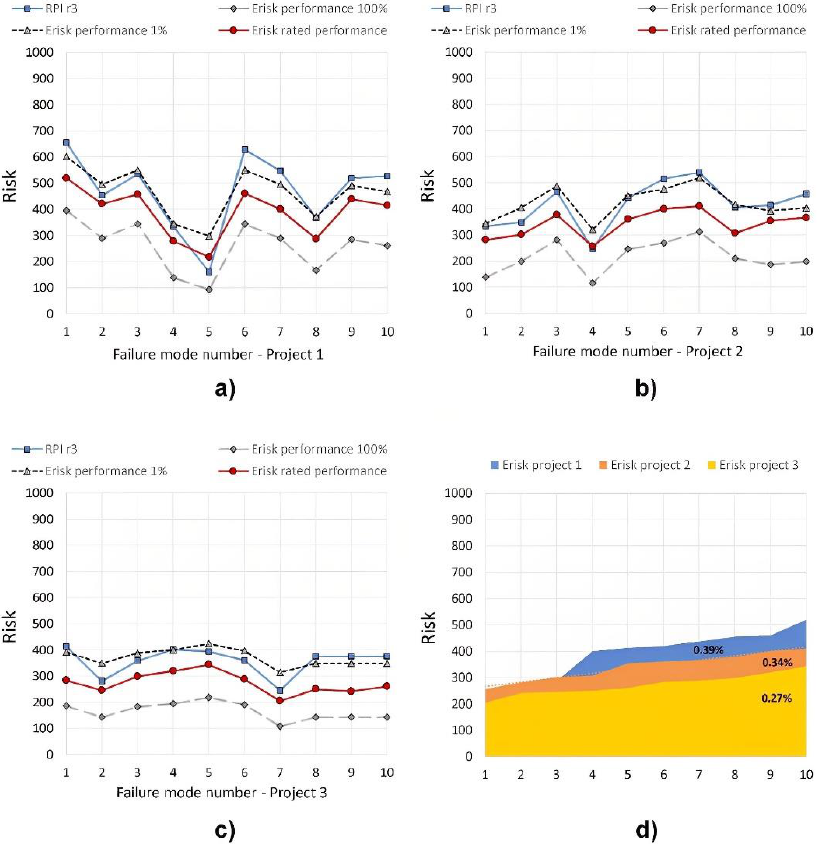
Figure 10. Case 3, risk results considering the weights QMI 0.2, Severity 0.1, Occurrence 0.4, Detectability 0.3. ( a ) project 1 results, ( b ) project 2 results, ( c ) project 3 results, ( d ) effective risk for projects 1, 2, and 3 considering the weights of Case 3.